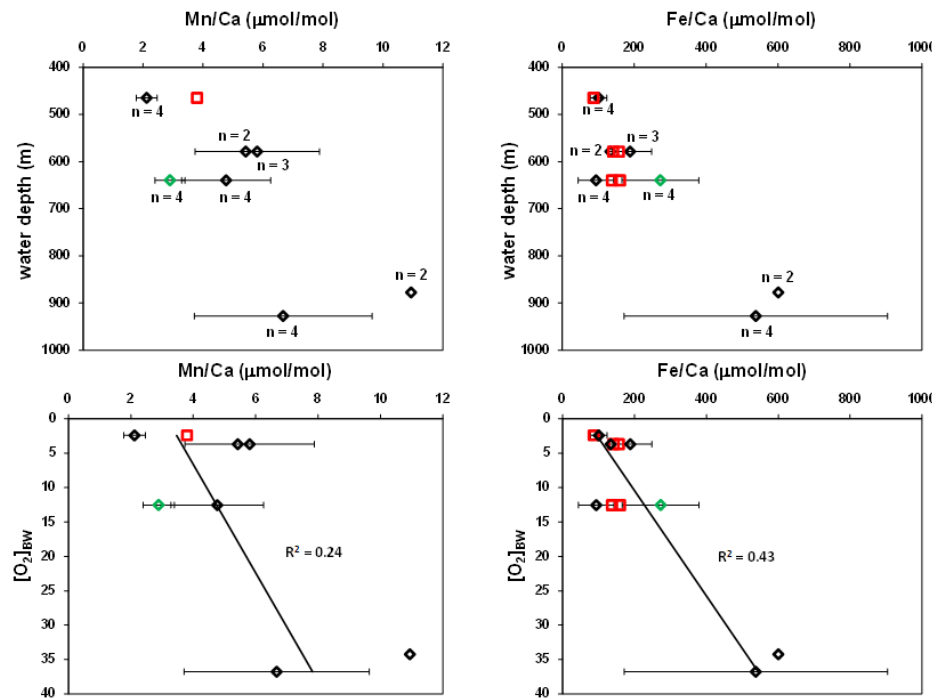
Fig. 9. Mn/Ca and Fe/Ca ratios in tests of Bolivina spissa plotted against water depth and [O 2 ] BW . Red squares indicate data points measured on bulk samples of 40 specimens with ICP-MS while diamonds indicate mean values from single specimens measured with SIMS. The specimens indicated by the black diamonds all have been treated with an oxidative cleaning procedure while the single green diamond represents an uncleaned specimen. Error bars on the SIMS data show the standard deviation between the different spots measured on a single specimen. Diamonds without error bars indicate mean values of only two measurements. The linear fits and their R 2 value are calculated from all measured datapoints, not from the mean values plotted here.